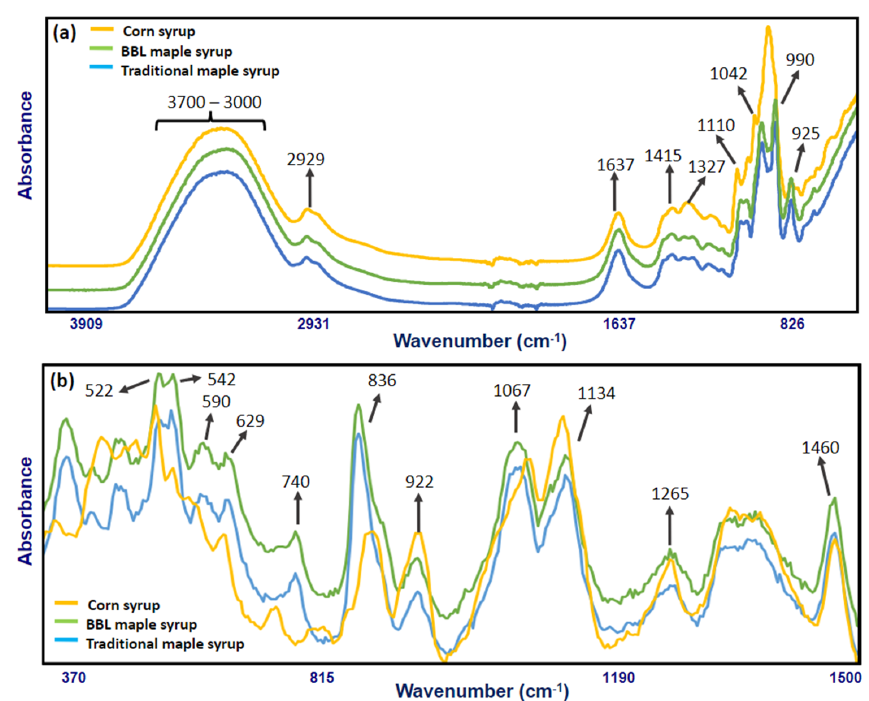
Figure 3. ( a )FT ‐ IR spectrum band positions and corresponding wavenumbers of traditional maple five ‐ reflections ZnSe crystal ATR system. ( b ) Raman spectrum, band positions and